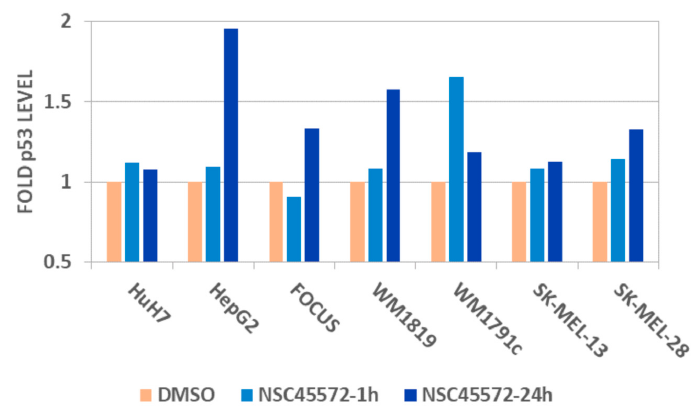
Figure 4. A graph showing the effect on p53 levels after treatment with 10 μ M of compound 1 (NSC45572) in a number of malignant cell lines (hepatocellular carcinoma: HuH7, HepG2, FOCUS; melanoma: WM1819, WM1791c, SK-MEL-13, SK-MEL-28) at two time-points (1 and 24 h). A systematic and in several cases (HepG2 cells) significant increase of p53 level is observed in most cell lines, especially after 24 h of treatment, with the exception of HuH7 cells that carry a mutant TP53 gene and the SK-MEL-13 line where the effect is limited. DMSO: dimethyl sulphoxide.